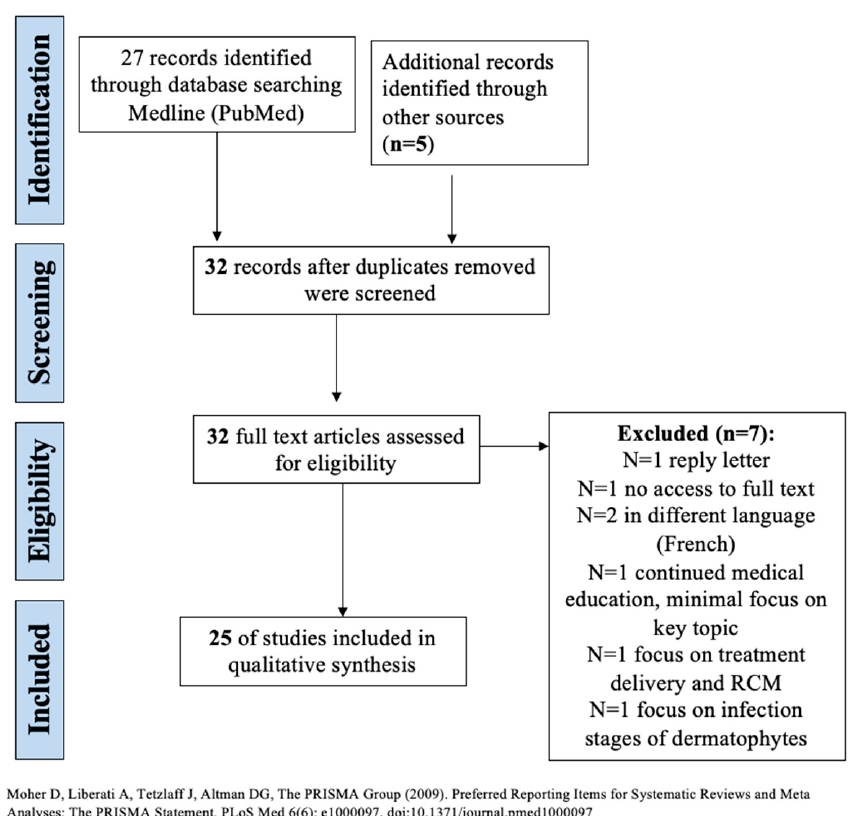
Figure 1. Screening, eligibility, inclusion, and exclusion of studies for systematic review.